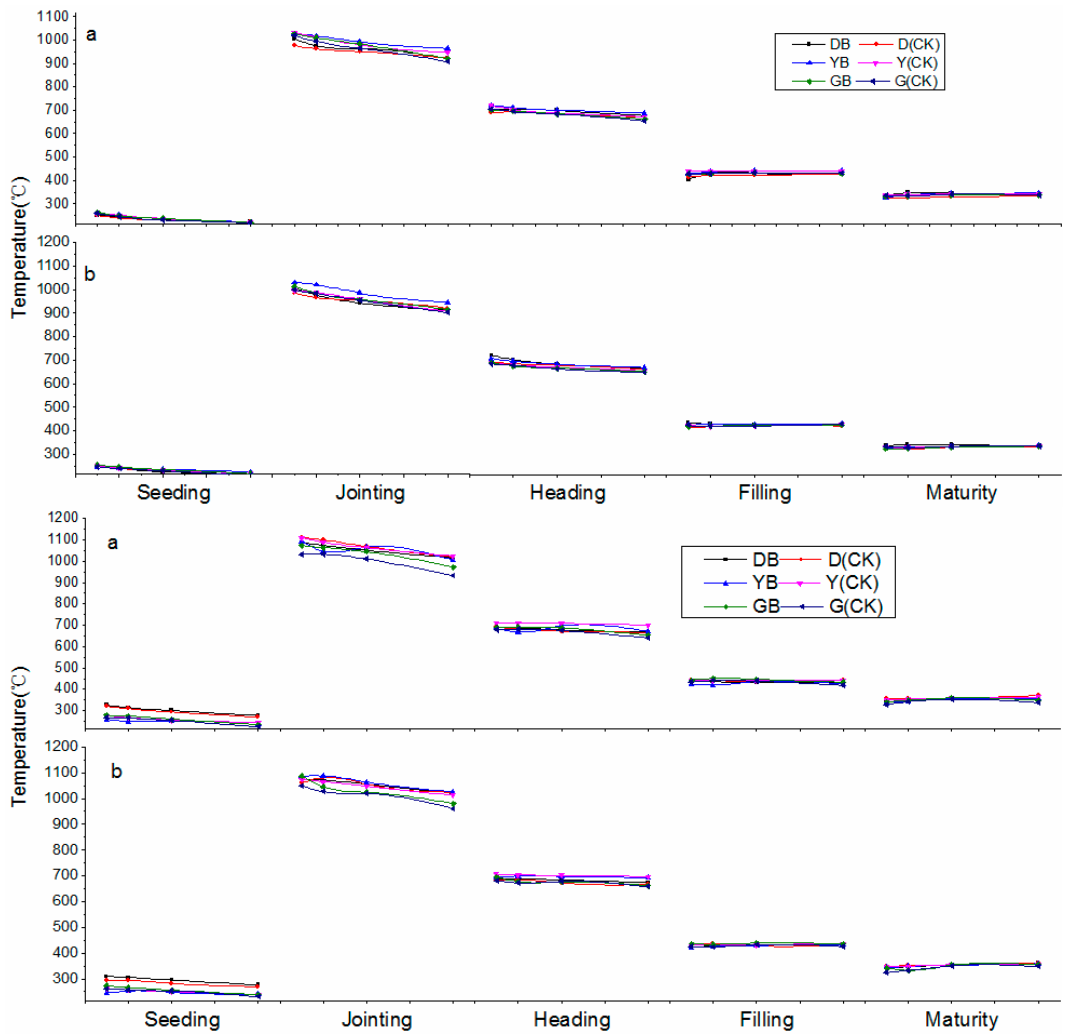
Figure 11. Characteristics of accumulated temperature change.